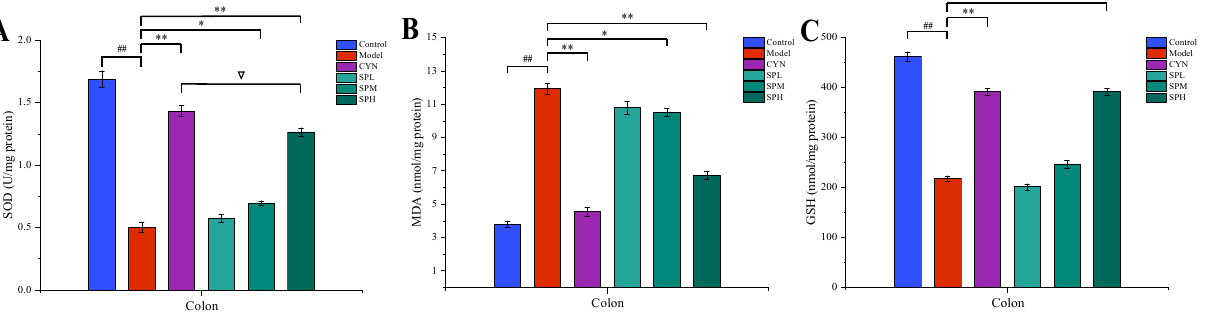
Figure 4. Effect of SP on ( A ) iNOS, ( B ) IL-6, ( C ) TNF- α and ( D ) MPO. (Data are expressed as the means ± S.E.M., n = 10). Compared with control group, ## p < 0.01; compared with model group, ** p < 0.01; compared with CYN group, ∇ p >0.05).